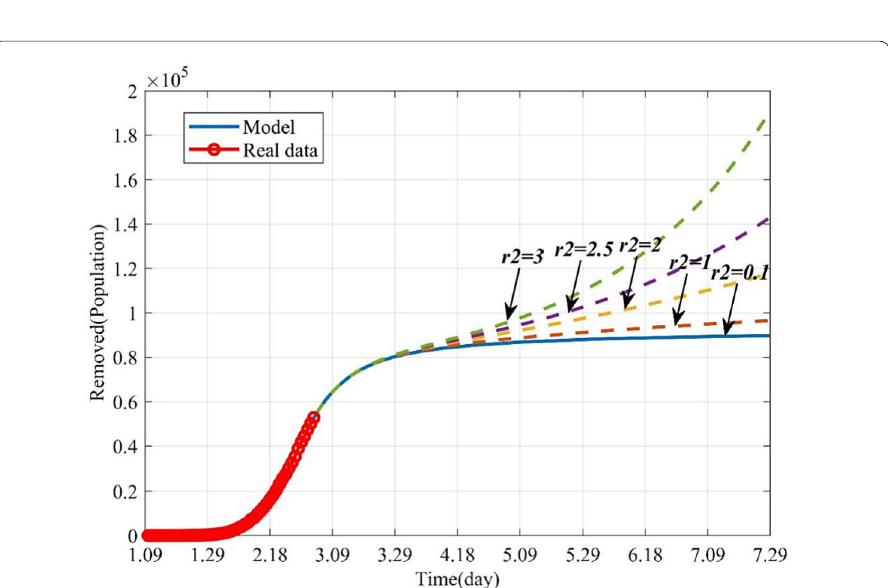
Figure 13 Dynamic trends of the removed with different r 2 . The solid line represents the trends of the removed with the current r 2 . The orange dotted line represents the trends of the removed when r 2 = 1. The yellow dotted line represents the trends of the removed when r 2 = 2. The purple dotted line represents the trends of the removed when r 2 = 2.5. The green dotted line represents the trends of the removed when r 2 =